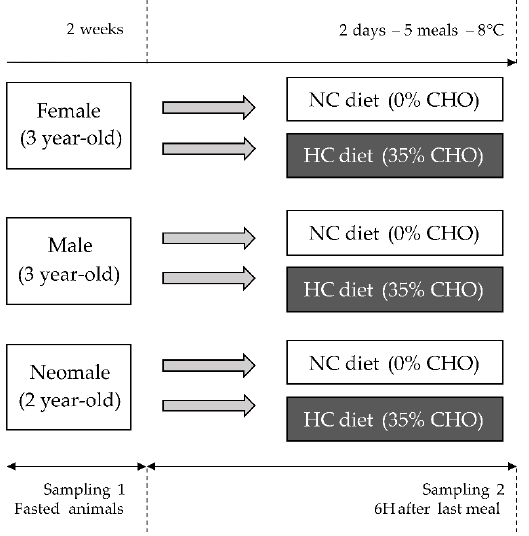
Figure 8. Experimental design. Mature female and male, and neomale, rainbow trout were fed either a diet containing no carbohydrates (NC) or containing 35% of carbohydrates (HC).